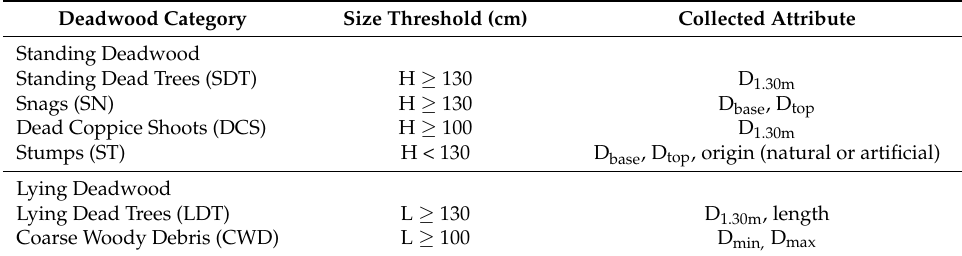
Table 1. Size thresholds and collected attributes of the deadwood categories. Deadwood Category Size Threshold (cm) Collected